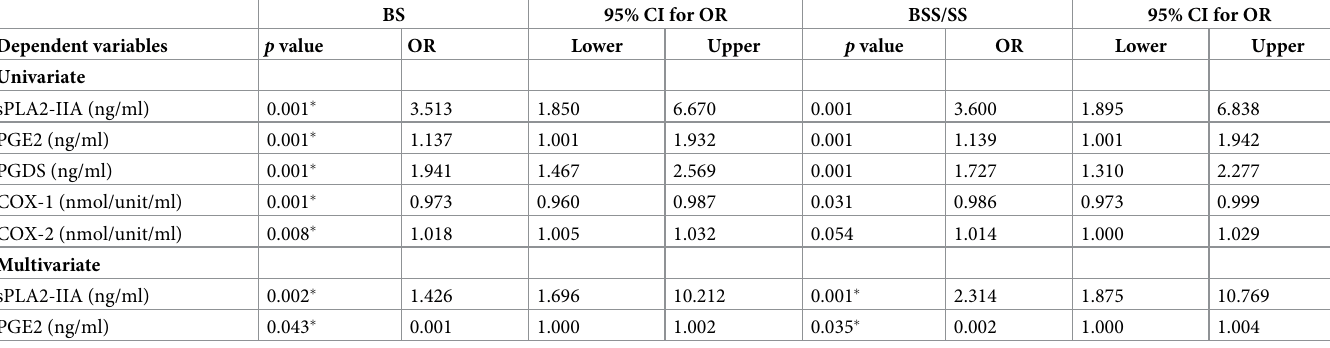
Table 2. Factors associated with sepsis syndrome patients (using Binary Logistic Regression).